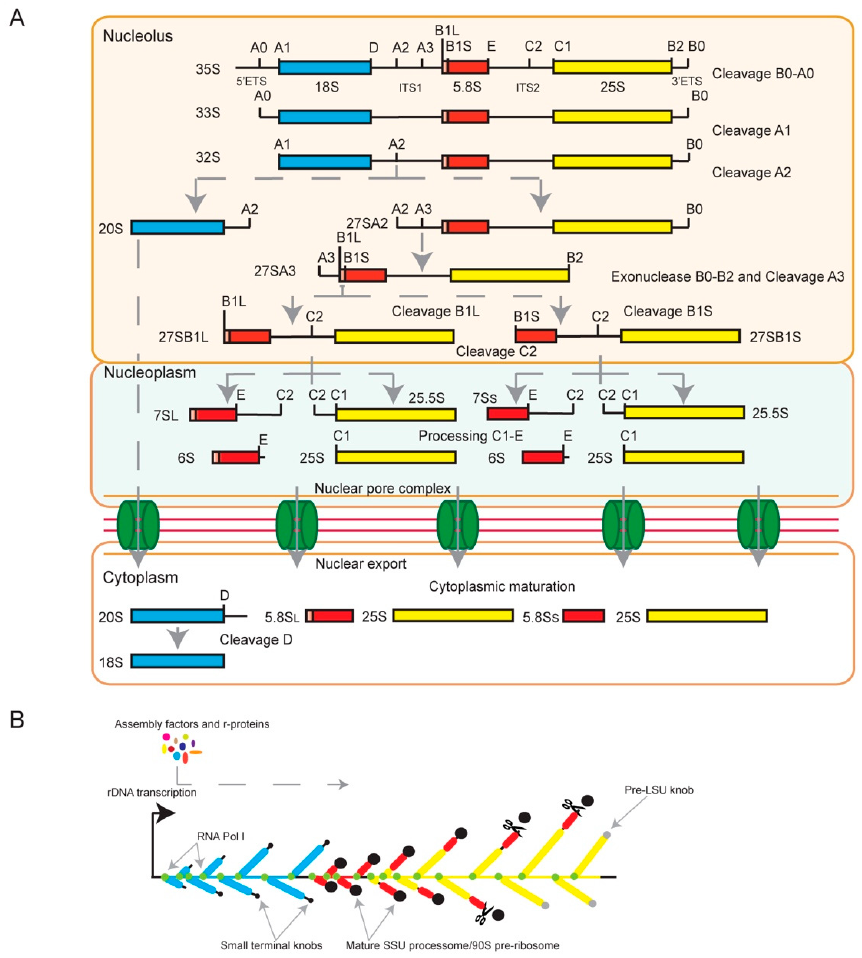
Figure 1. Processing of pre-ribosomal RNA (pre-rRNA) and small subunit (SSU) processome formation in the yeast Saccharomyces cerevisiae . ( A ) Scheme of 35S pre-rRNA processing steps. The 35S precursor is cleaved and trimmed at different sites to form the mature 18S (blue), 5.8S L , 5.8S S (red) and 25S (yellow) rRNAs. Processing takes place in different cellular compartments (nucleolus, nucleoplasm and cytoplasm), represented by rectangles. Cleavage sites are indicated on the transcripts and are detailed in the text. The final maturation steps occur in the cytoplasm once the late precursors have been exported via the nuclear pore complex (NPC, colored in green). ( B ) Representation of SSU processome formation. The ribosomal DNA (rDNA) is transcribed by RNA polymerase I (Pol I) (green circles). When visualized by electron microscopy, actively transcribed rDNA units appear as Christmas trees, wherein chromatin forms the trunk, nascent rRNA transcripts are the branches, and the terminal knob seen at the 5 ′ end of transcripts is the forming SSU processome. The small black circles represent the newly formed SSU knobs and the larger black circles are the mature SSU knobs, where the 5 ′ ETS and the 18S rRNA are packed. The large SSU knob is then cleaved at site A2 (represented by the black scissors). The large subunit precursor (pre-LSU) knobs are shown in grey circles. This schematic representation is adapted from Osheim et al. [70].